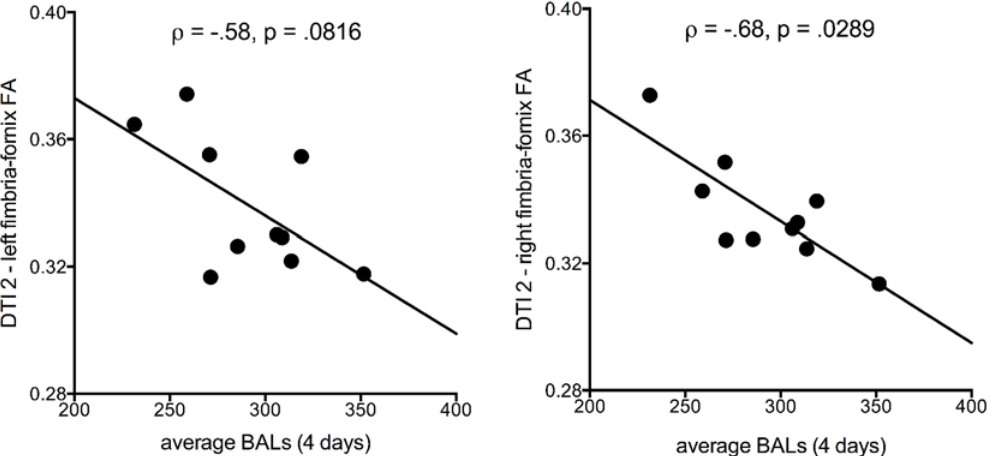
Fig 8. Correlations between left and right fimbria-fornix FA and average BALs across the 4 days of binge alcohol treatment. Bilateral results were also significant (Rho = -.65, p = .0425).